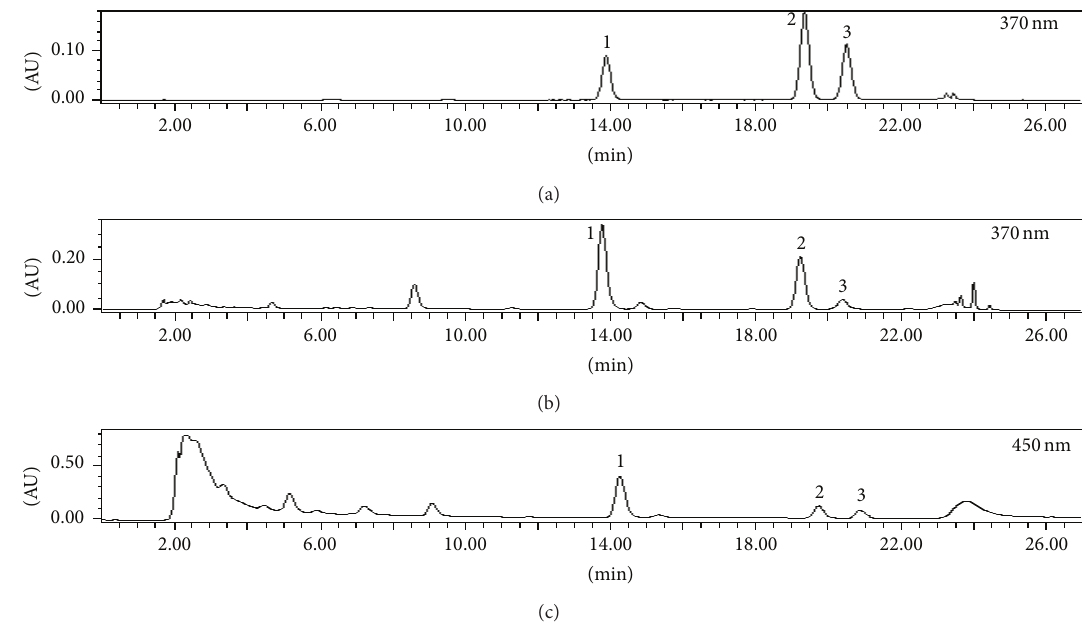
Figure 1: Combined chromatograms of chromatographic elution of a mixture of flavonoid standards (a), Ginkgo biloba L. leaf extract (b), and postcolumn reaction with CUPRAC with Ginkgo biloba L. leaf extract (c). For exact compound refer to Table